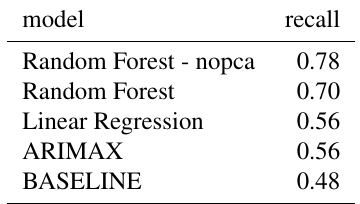
Table 4: Summary results for the whole system with notification filtering and 1 ∗ std _ de v as the anomaly classification prediction error threshold. Notifying on the anomaly at the time of its end is not counted as valid